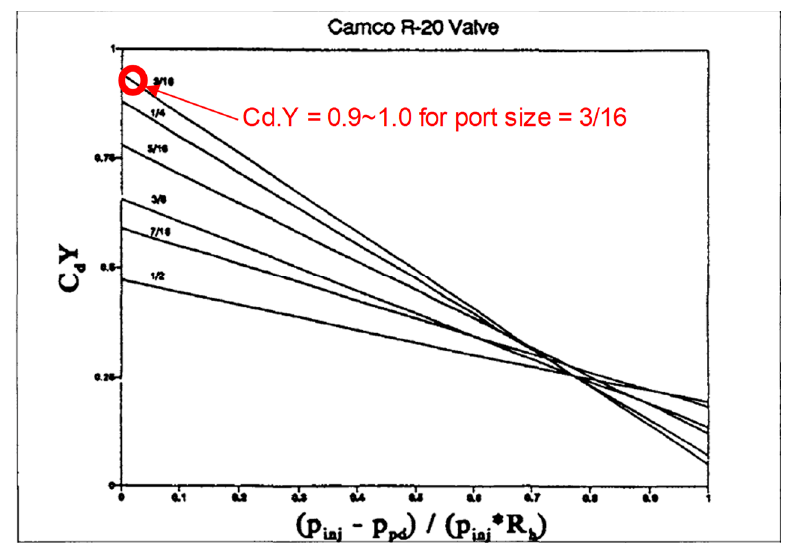
Figure 7. Cd estimation for the Camco R-20 valve [24].